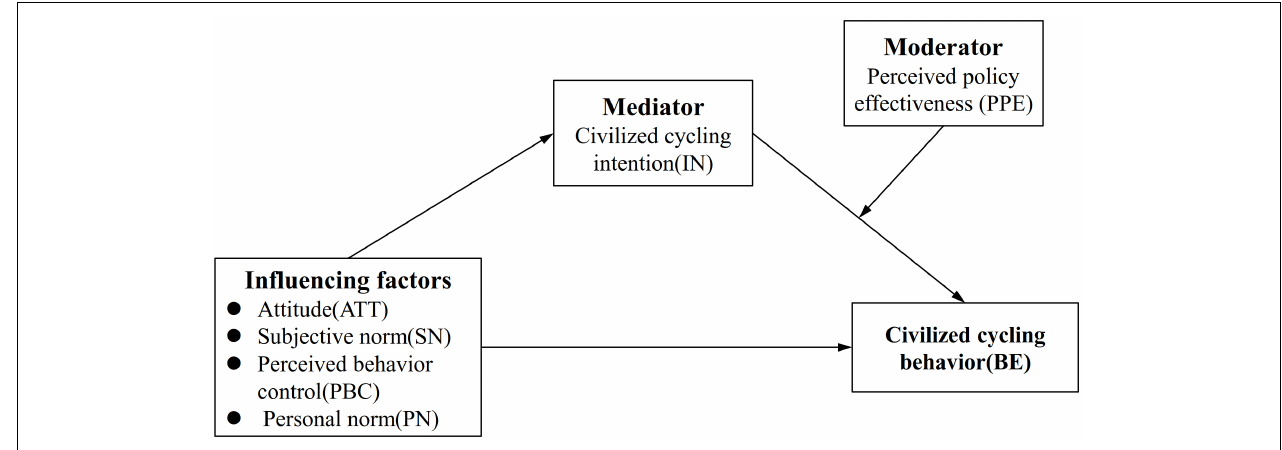
FIGURE 1 | A theoretical framework of users’ civilized cycling